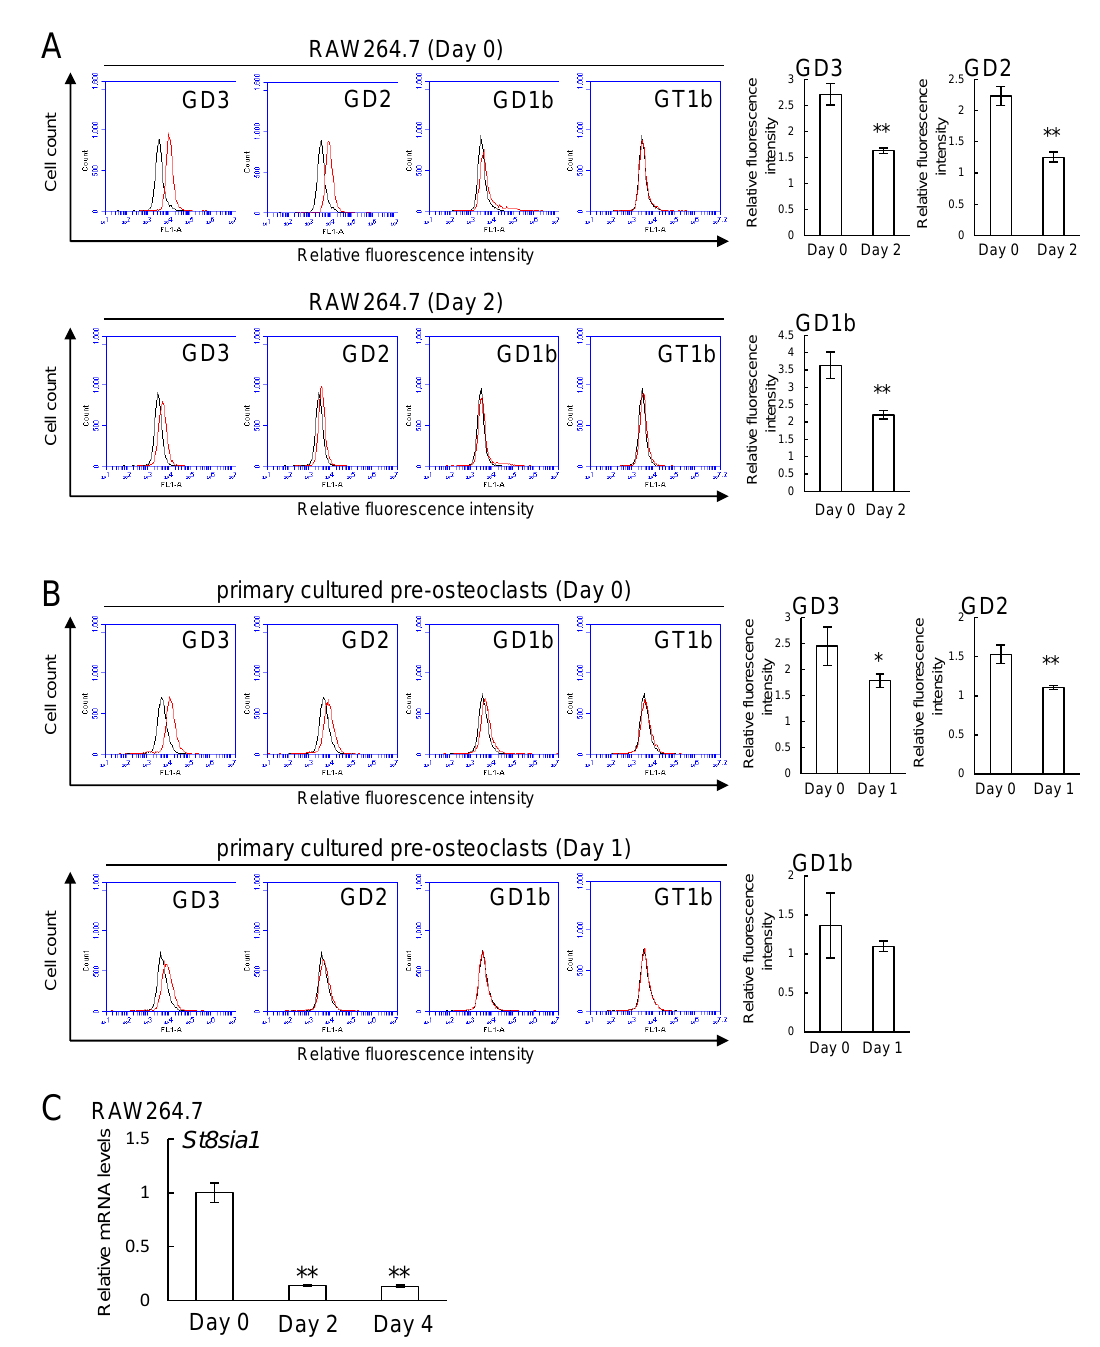
Figure 3. Expression of b-series gangliosides (GD3, GD2, GD1b, and GT1b) and GD3 synthase gene ( St8sia1 ) in RAW264.7 cells and primary cultured pre-osteoclasts in the presence or absence of RANKL. ( A ) Expression of b-series gangliosides in RAW264.7 cells on days 0 and 2 after administration of RANKL ( n = 3). ( B ) Expression of b-series gangliosides in primary cultured pre-osteoclasts on days 0 and 1 after administration of RANKL ( n = 3). Red line: anti-gangliosides (GD3, GD2, GD1b, or GT1b) monoclonal antibodies (mAbs) ( + ), gray line: anti-gangliosides mAbs (-). The relative expression level (GD3, GD2, and GD1b) was defined as the ratio of the fluorescence intensity for the anti-gangliosides (GD3, GD2, or GD1b) monoclonal antibodies (mAbs) ( + ) to the fluorescence intensity for the anti-gangliosides mAbs (-). ( C ) mRNA expression of St8sia1 in RAW264.7 cells on days 0, 2, and 4 after administration of RANKL ( n = 3). Data are expressed as mean ± SD. The single (*) and double asterisks (**) indicate p < 0.05 and p < 0.01,